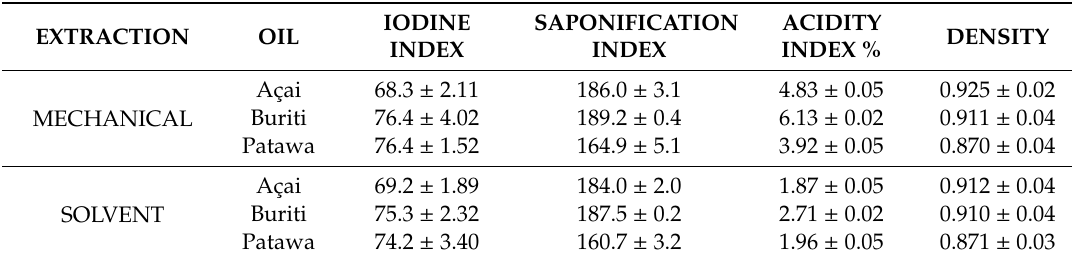
Table 2. Quality indexes for açai, buriti, and patawa oils obtained by mechanical and solvent extraction.